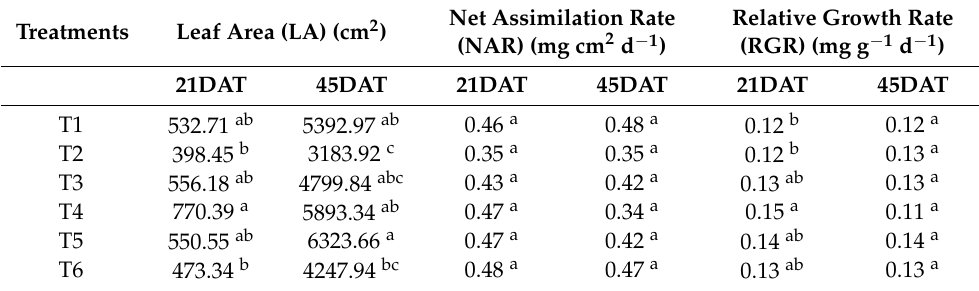
Table 2. Effects of chemical (mono-super phosphate), organic (rock phosphate), and PGPB (biofertil- izer) treatments on some vegetative-growth traits (leaf area (cm 2 ), net assimilation rate (mg cm − 2 day − 1 ), relative growth rate (mg g − 1 day − 1 )) of tomato plants grown under greenhouse conditions 21 and 45 days after transplantation (DAT). Treatments Leaf Area (LA) (cm 2